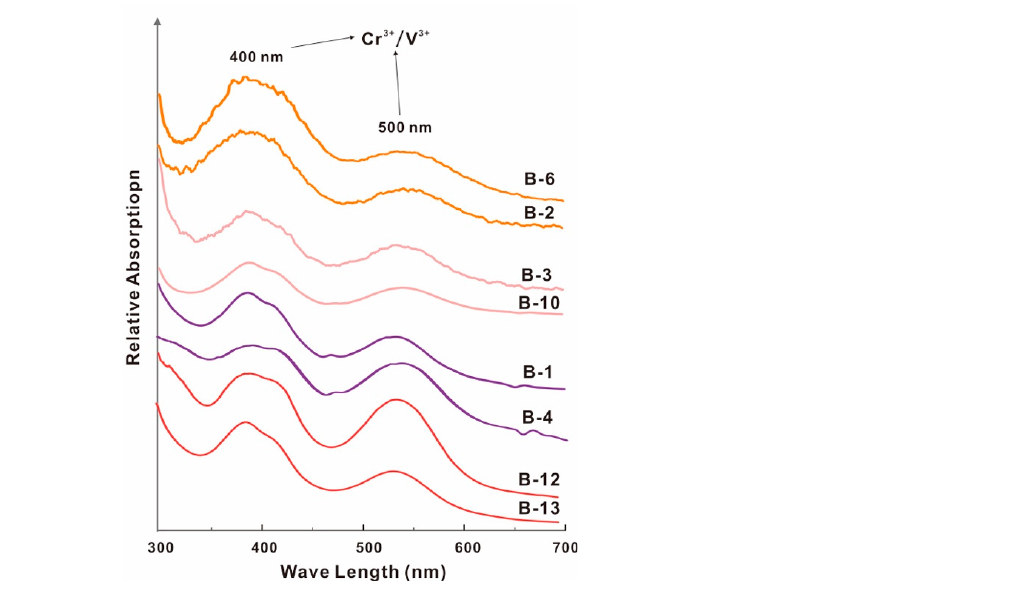
Figure 8. The representative UV–Vis–NIR spectrum of Mogok spinel is characterized mainly by Cr 3+ or V 3+ absorption features.